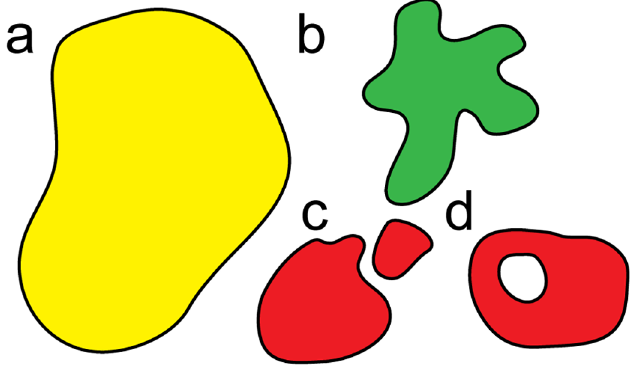
Fig 3. Schematic representation of the allowed and disallowed changes of the boundary in the AVM. An initial configuration with the topology of a disk (a) is allowedto developpronounced fingers (b). However, it is not possibleto split into two domains(c) or developa hole (d), which would both lead to the introduction of a new boundarylines, and therefore lead to changesin the